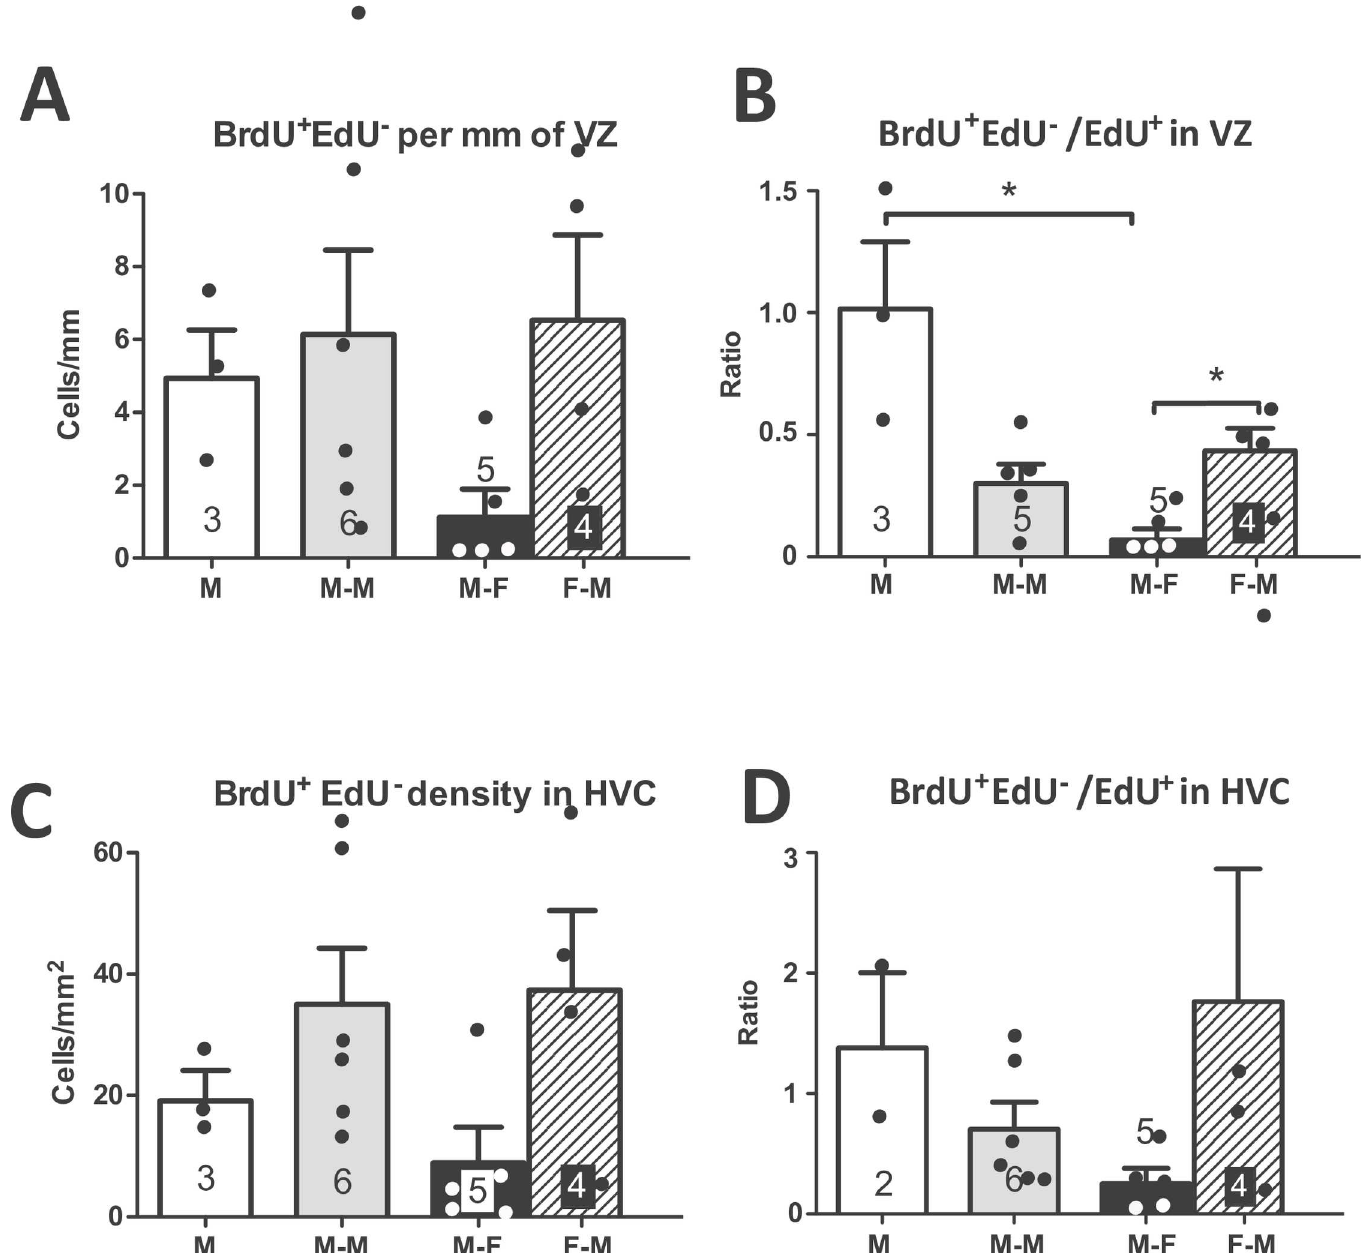
Fig 7. Number of BrdU + EdU - cells in the VZ dorsal to HVC per mm (A) and density (number per mm 2 ) of BrdU + EdU - cells in HVC (C). Ratio of BrdU + EdU - over EdU + cells in VZ (B) and HVC (D). M: male-alone, M-M: male housedwith anothermale, M-F: male housedwith female, F-M: female housedwith a male. The figures on the bars indicatethe numbersof availabledata points. * = p <